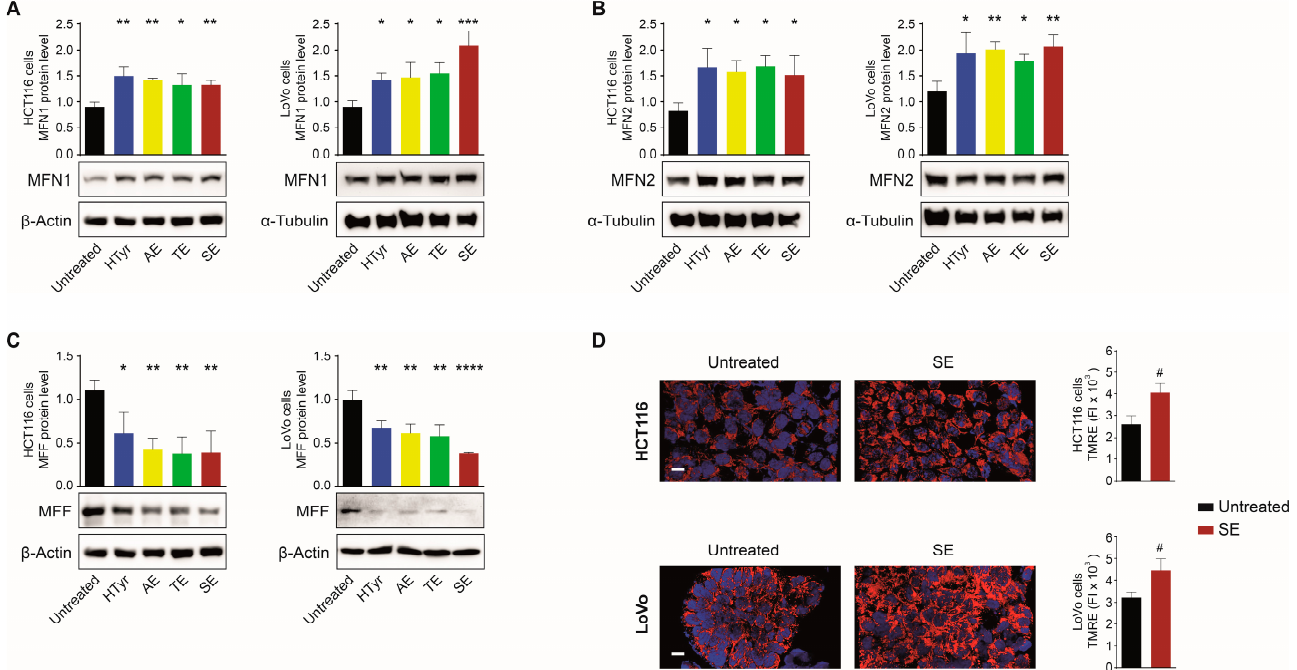
Figure 4. HTyr and OPWPs extracts influence mitochondrial dynamics. Protein lysates from HCT116 and LoVo cells treated with HTyr or OPWPs extracts were analyzed by Western blot for MFN1 ( A ), MFN2 ( B ) and MFF ( C ). Protein levels were calculated after normalization to β -Actin or α -Tubulin, used as loading controls. Three independent experiments were performed; the bands corresponding to β -Actin in ( A , C ) for HCT116 cells and shown here are the same, since the MFN1 and MFF proteins were detected on the same filter. ( D ) Representative confocal fluorescence microscopy images of HCT116 and LoVo cells treated with SE for 72 h and stained with TMRE to evaluate mitochondrial morphology. The histograms on the right illustrate the values of the mitochondrial mass calculated as Fluorescence Intensity (FI) with the ImageJ software, as described in Materials and Methods. Statistical significance was considered when * p < 0.05, ** p < 0.01, *** p < 0.001, or **** p < 0.0001 (ANOVA with Dunnett’s post-test) for ( A – C ) and # p < 0.05 ( t- test) for ( D